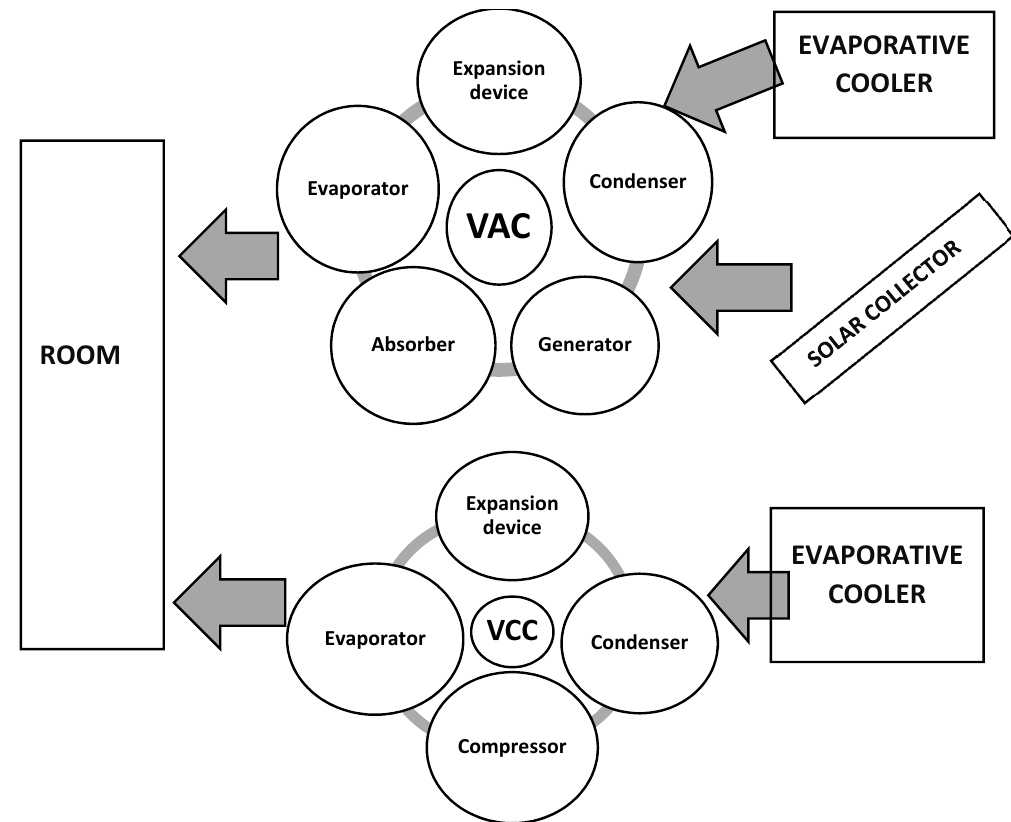
Fig.4 Combined Vapor compression cooling with solar vapor absorption cooling and evaporative cooling of condenser